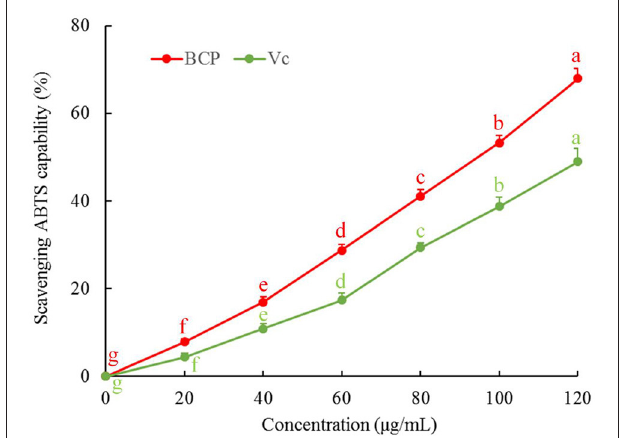
FIGURE 3 | ABTS free radical scavenging capacity of blood cora polysaccharides. a − g Mean values with different letters over the bar are significantly different ( P < 0.05) according to Tukey’s honestly significant difference.